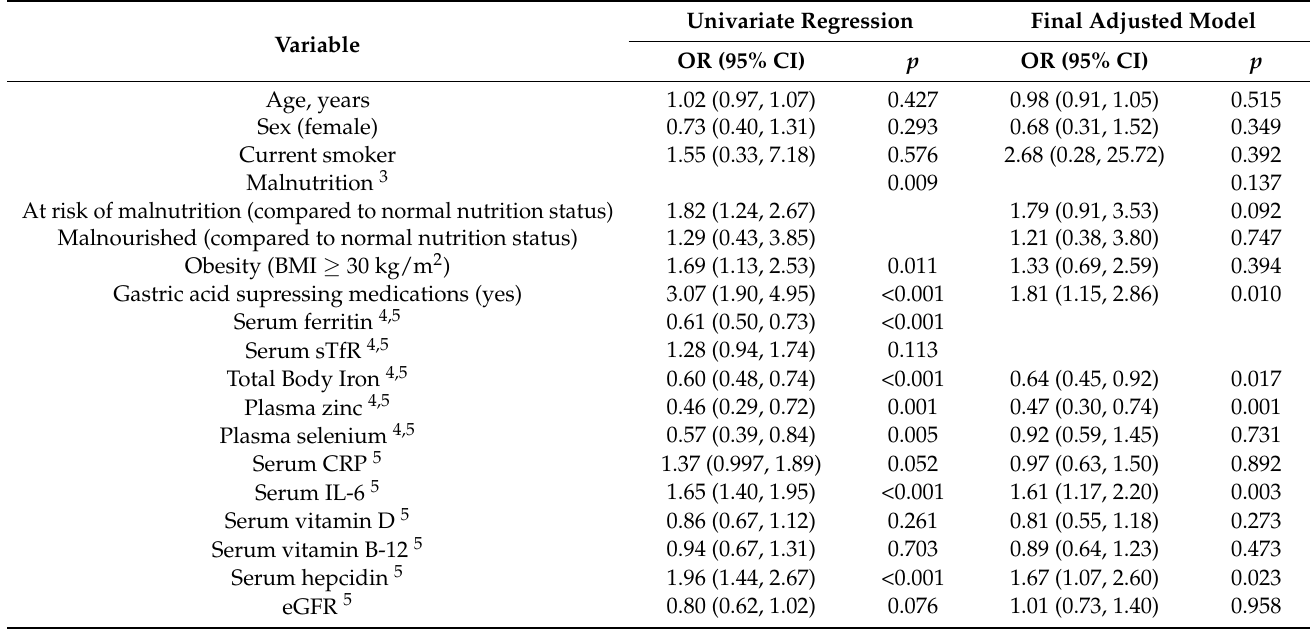
Table 3. Logistic regression for anemia in 278 New Zealand aged-care residents of European ethnicity 1,2 . Univariate Regression Final Adjusted Variable